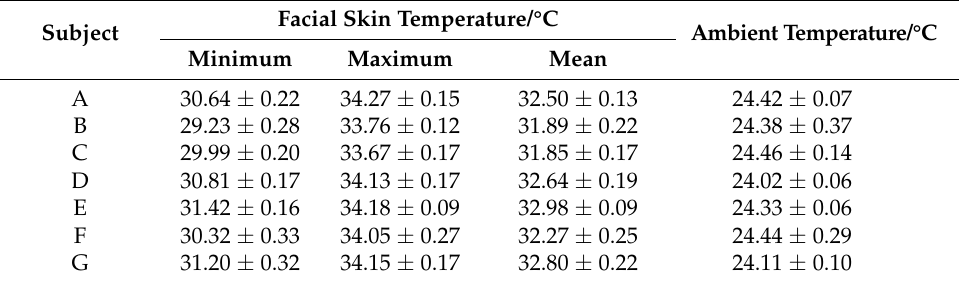
Table 1. Mean values ± SD of the minimum, maximum, and mean facial skin temperature. The number of thermal infrared images for each subject was